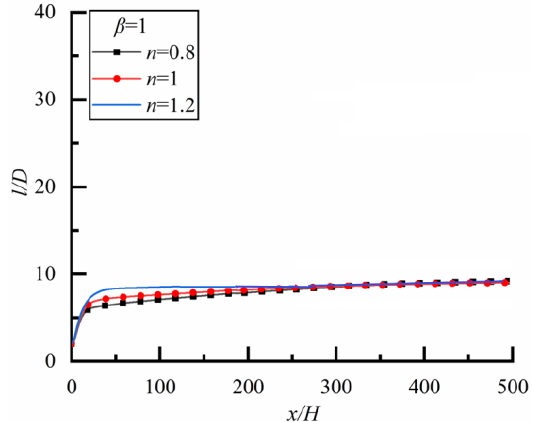
Figure 5. Changes of l/D along flow direction for different n ( Re =20).